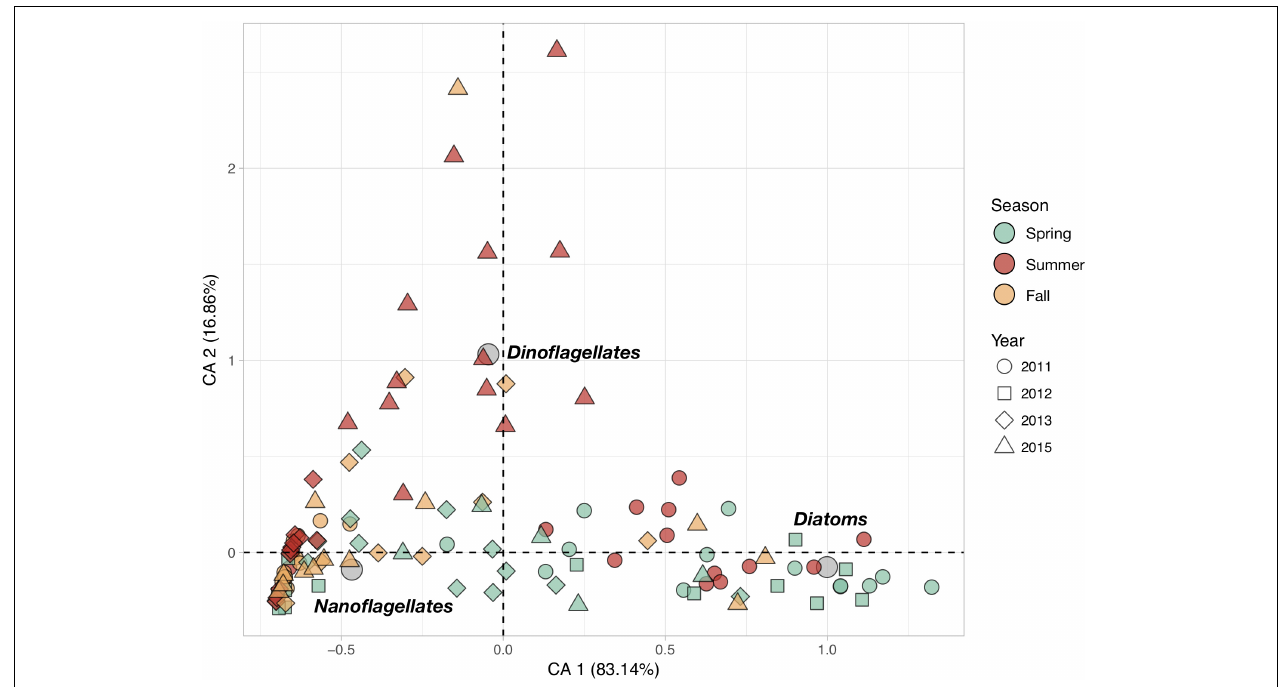
FIGURE 3 | Correspondence Analysis (CA) based on the cell counts of the three main phytoplankton groups (Diatoms, Dinoflagellates and Nanoflagellates). The color of the symbols corresponding to sampling stations (objects) were set according to sampling season (Spring, Summer and Fall), while their shape was changed as a function of the sampling year (2011, 2012, 2013, and 2015) to evidence the seasonal and inter-annual variations. Gray circles represent the position of the scoring variables (phytoplankton groups) in the reduced